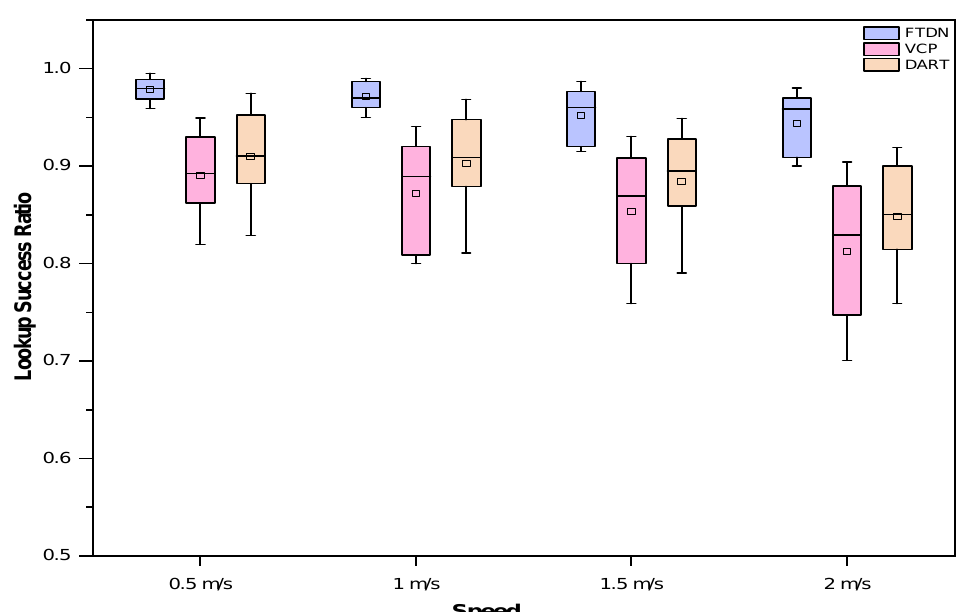
Figure 6. Lookup success ratio results, as boxplots, against different node moving speeds with varying network